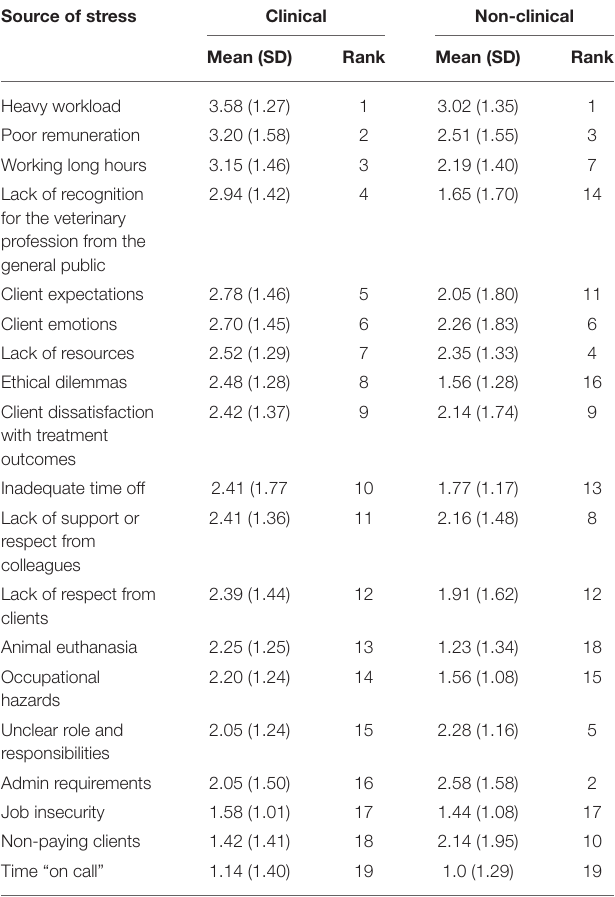
TABLE 4 | Potential sources of stress for clinical and non-clinical staff. Source of